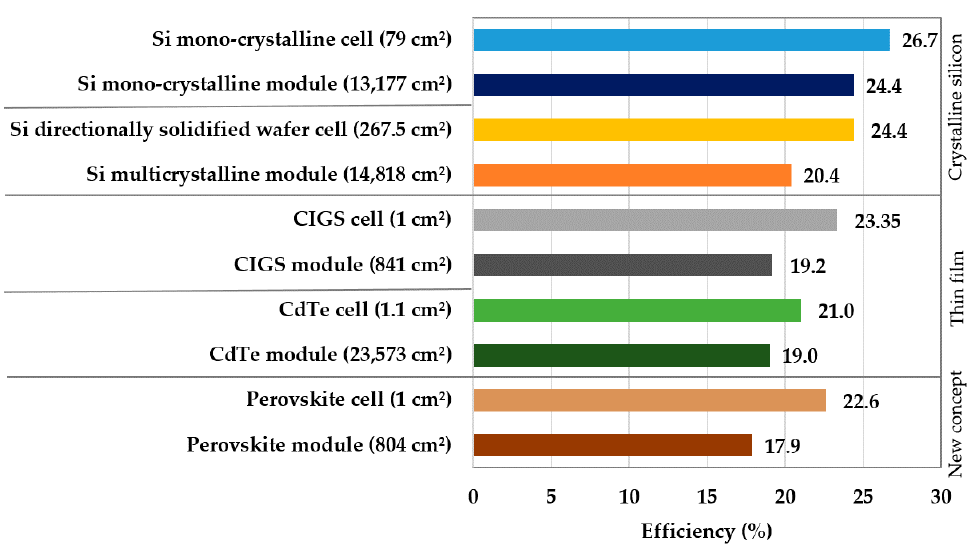
Figure 4. Best cell and module efficiencies found in the literature. Data from Green et al. [69].